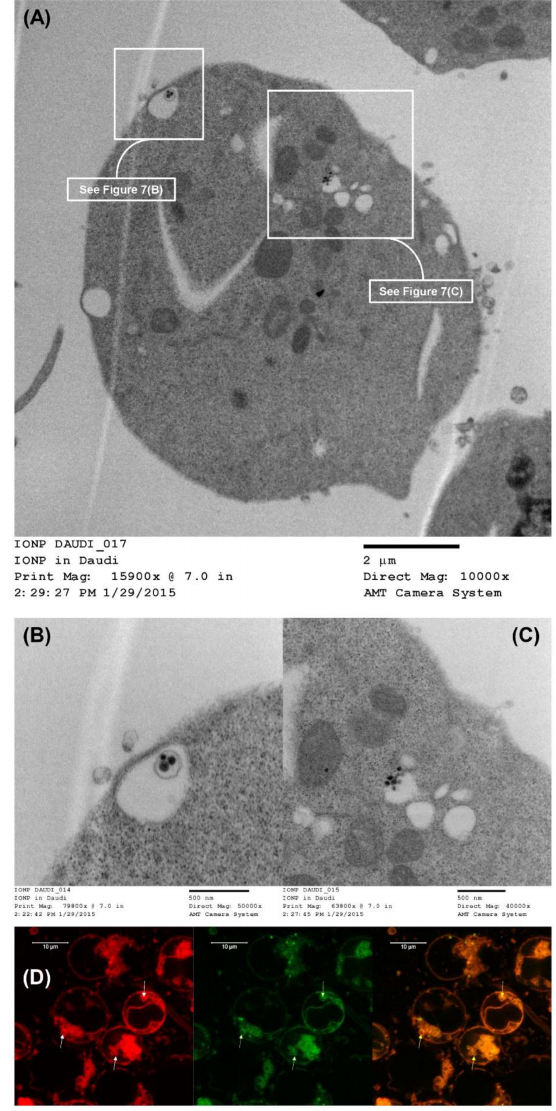
Figure 7. ( A ) TEM image of LCCTLA intracellular localization in Daudi cells; ( B ) Enlarged from Figure 7A showing an MLV of MLCCTLA inside an endosomal structure; ( C ) Enlarged from Figure 7A showing SUV’s of MLCCTLA inside an endosomal structure; and ( D ) CLSM image of intracellular localization of LCCTLA in